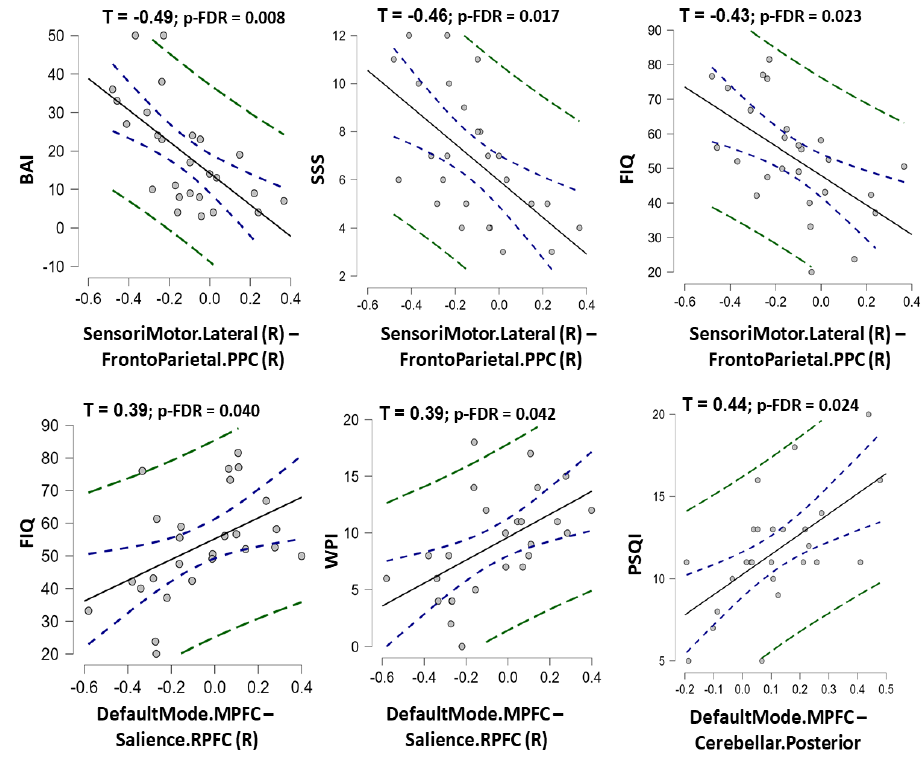
Figure 5. The charts show correlation between the predictive resting-state functional connectivity features and clinical measurement scores in fibromyalgia patients. The Kendall’s Tau correlation coefficients (with p -value corrected by false discovery rate) were shown for statistically significant correlations. Note: SensoriMotor.Lateral (R)–FrontoParietal.PPC (R) = the functional connectivity between the lateral sensorimotor network and the posterior parietal cortex node of frontoparietal network; DefaultMode.MPFC-Salience.RPFC (R) = the functional connectivity between the medial